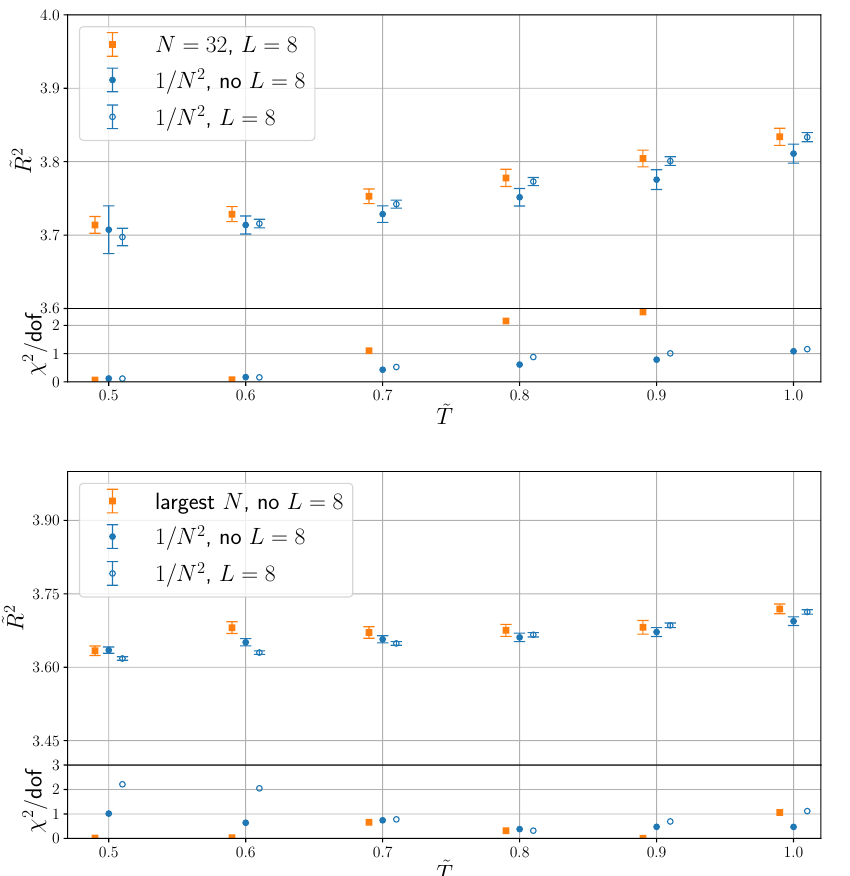
Figure 17. [Upper] The values of ~ R 2 in the ungauged theory as a function of the temperature for three di(cid:11)erent extrapolations: one continuum extrapolation at (cid:12)xed N = 32 and two simultaneous continuum large- N extrapolations. The error bars of the individual points at (cid:12)xed N , L and ~ T used in the continuum extrapolations have been increased by a factor of four. [Lower] Same as above, but for the gauged theory. The error bars of the individual points at (cid:12)xed N , L and ~ T used in the continuum extrapolations have been increased by a factor of